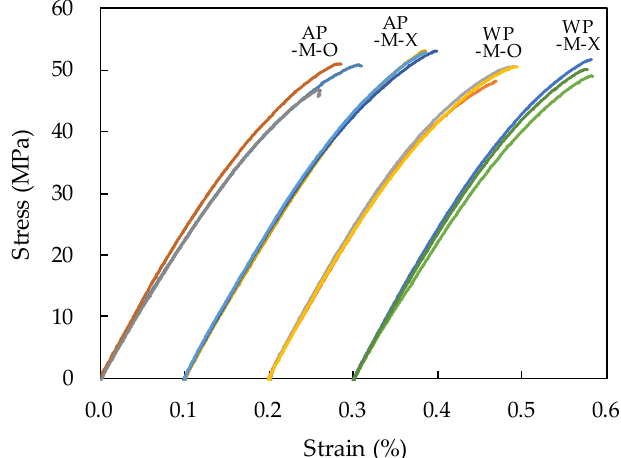
Figure 13. Stress–strain relationship of specimens produced by direct casting in cylindrical molds (the strain in all graphs starts from 0).